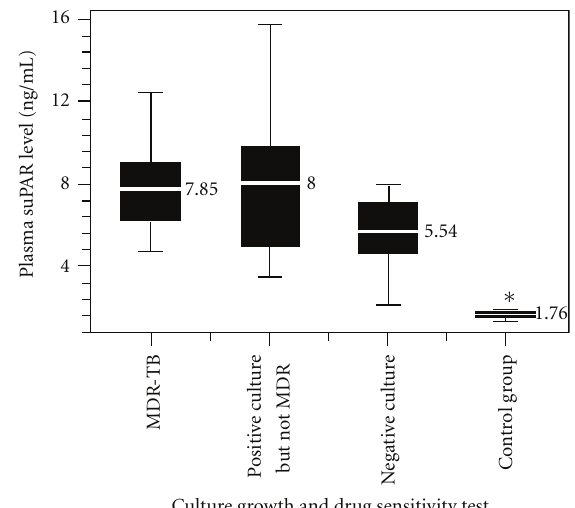
Figure 1: Measurement of plasma soluble urokinase plasminogen activator receptor (suPAR) levels based on culture growth and drug